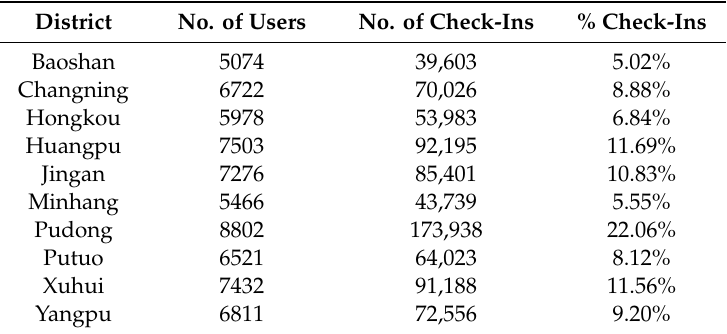
Table 6. User and check-in distributions in districts of Shanghai.